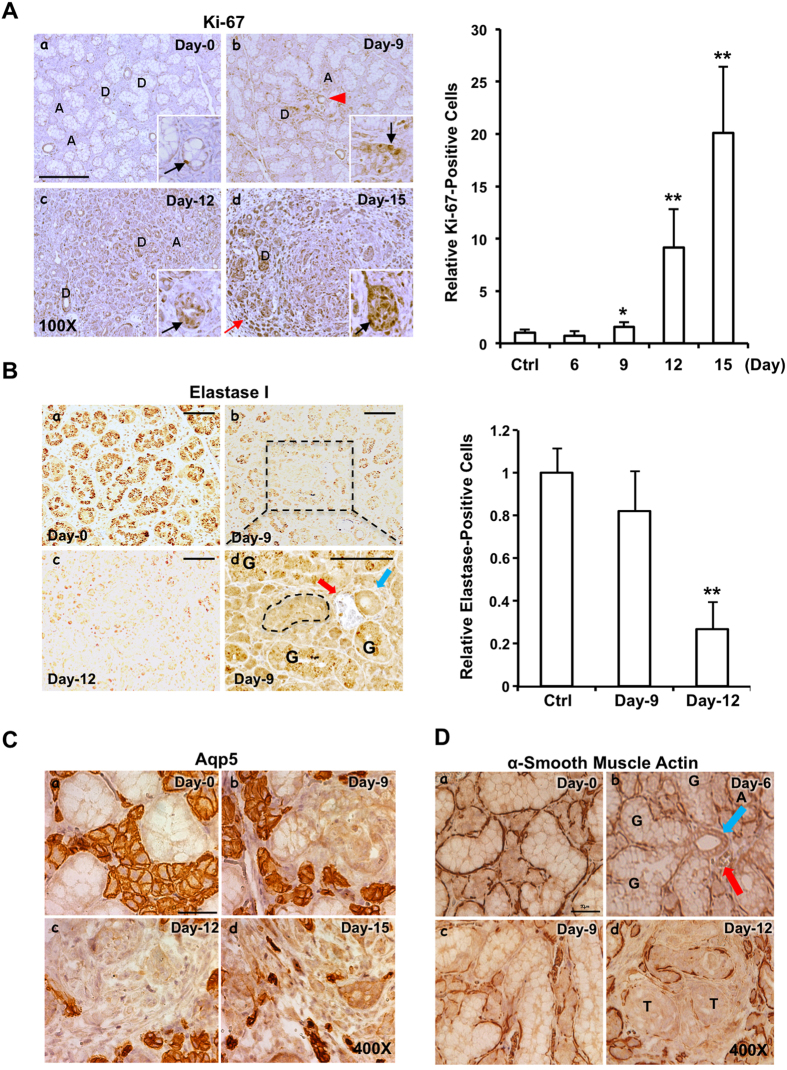
Cell proliferation starting from day-9 following oncogenic KRAS activation.(A) Nuclear Ki-67-positive cells increased mainly at the ductal cells starting from day-9 post KRASG12V induction. Scale bars: 250 μm; inset: 200X; A: acini; D: duct; black arrow: nuclear Ki-67-positive ductal cell; red arrow: nuclear Ki-67-positive fibroblast; red arrowhead: blood vessel. The relative fold change in the nuclear Ki-67-positive staining with the level in the SMGs of LGL-KRasG12V;Ela-CreERT mice prior to Tam-feeding (Ctrl) set as 1. Results are shown as mean ± S.D. enumerated from 6 randomly selected non-overlapping fields (10X) by Image-Pro Premier 9.0; *p < 0.05, **p < 0.01. (B) Elastase I accumulation in the SMG ductal cells of LGL-KRasG12V;Ela-CreERT mice decreased during the course of tumorigenesis (left panels). Panel d (enlarged from boxed region in panel b): elastase I staining was lost in a GCT (shown by dotted line, panel d) near a dyad structure of a striated duct (blue arrow) and a blood vessel (red arrow); residual elastase I staining was visualized in some GCTs (label with G). Scale bar: 100 μm (panels a–c:); 100 μm (panel d, enlarged from b). The relative fold change in the elastase I-positive staining (right panel). Quantitative analyses of elastase I-positive staining with level at control SMGs set as 1. Results are shown as mean ± S.D. enumerated from 5 randomly selected non-overlapping fields (10X) by Image-Pro Premier 9.0; **p < 0.01. (C) Loss of AQP5 staining during KRASG12V-induced tumorigenesis. Immunochemical staining with an anti-AQP5 antibody in the SMGs of LGL-KRasG12V;Ela-CreERT mice at indicated time points following TAM-feeding. Scale bar: 50 μm. (D) Gradual loss of α-smooth muscle actin (αSMA) expression during early tumorigenesis. The earliest loss of αSMA occurred on day-6 in GCTs near a dyad structure of a striated duct (blue arrow) and a blood vessel (red arrow). Scale bar: 50 μm; G: GCT; T: tumor cell masses.